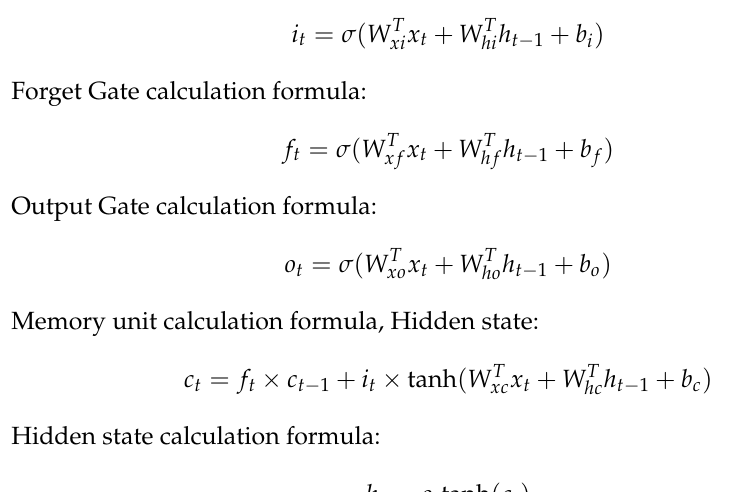
Figure 4. LSTM unit structure.